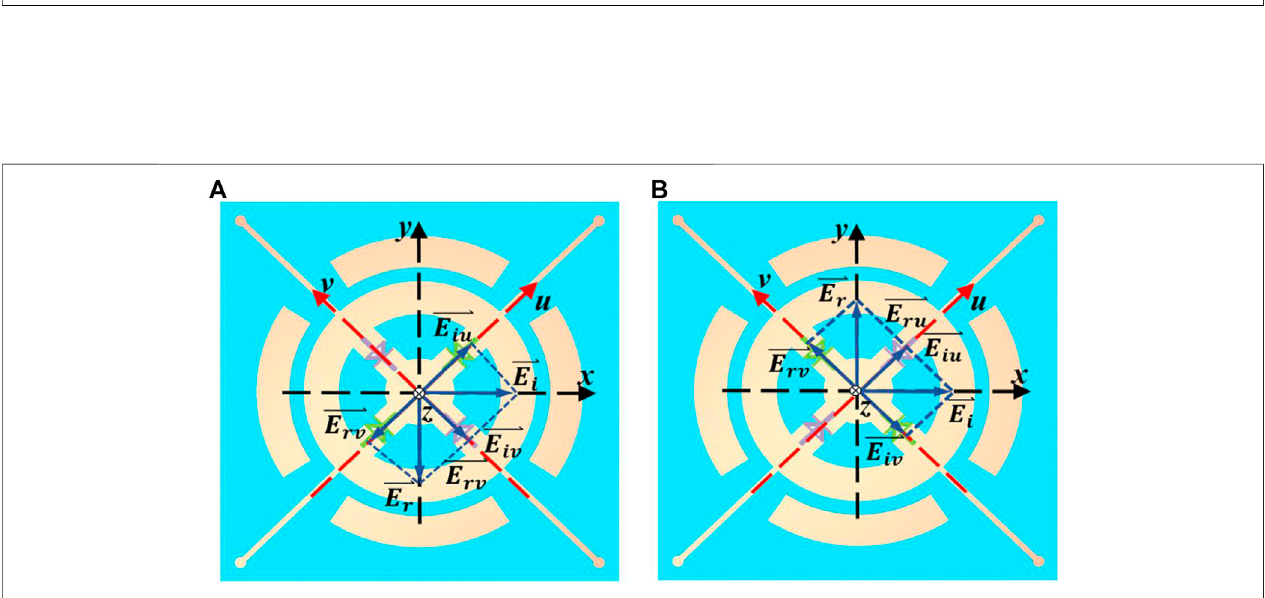
FIGURE 8 | Schematic diagram of the synthesis and decomposition of the incident electric fi eld and the re fl ected electric fi eld under x -polarized incidence. The re fl ected electric fi eld is along the (A) y and (B) - y directions.